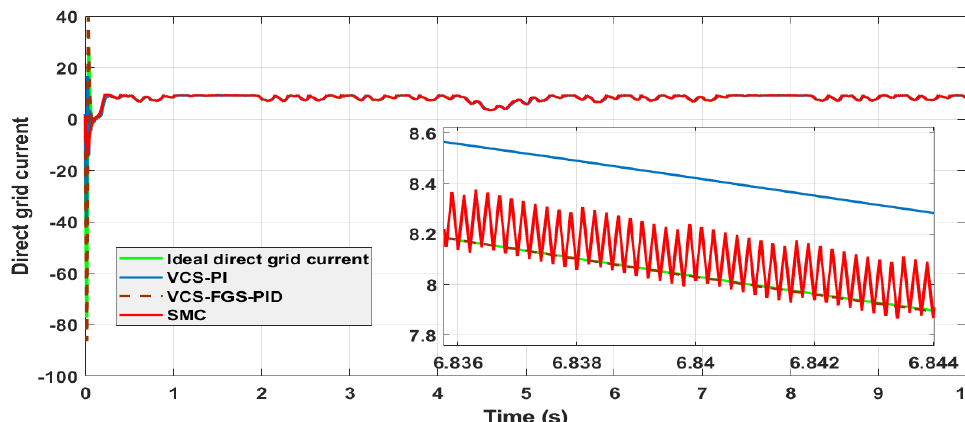
Figure 32. Direct grid current.